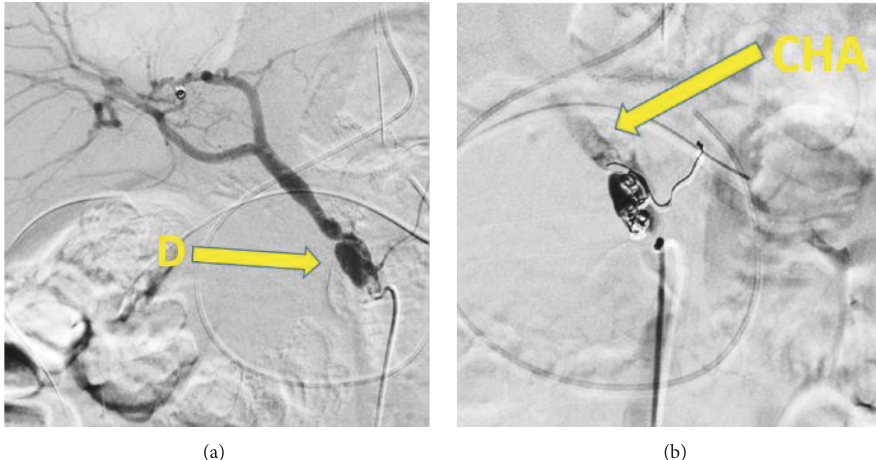
Figure 5: Coil embolization was performed for the aneurysm of common hepatic artery. D: dissection; CHA: common hepatic